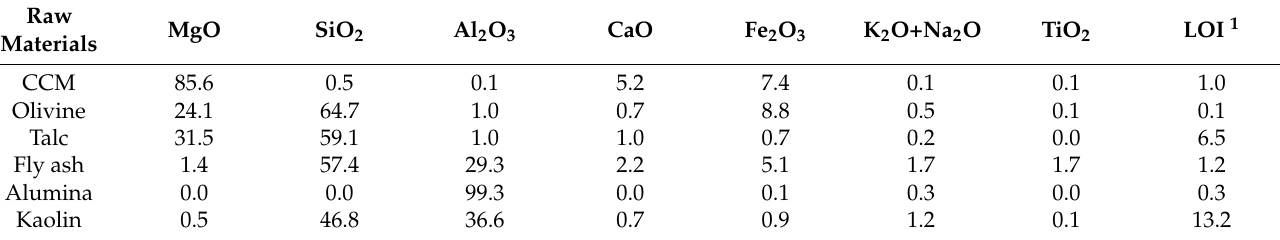
Table 1. The chemical composition of all used raw materials.